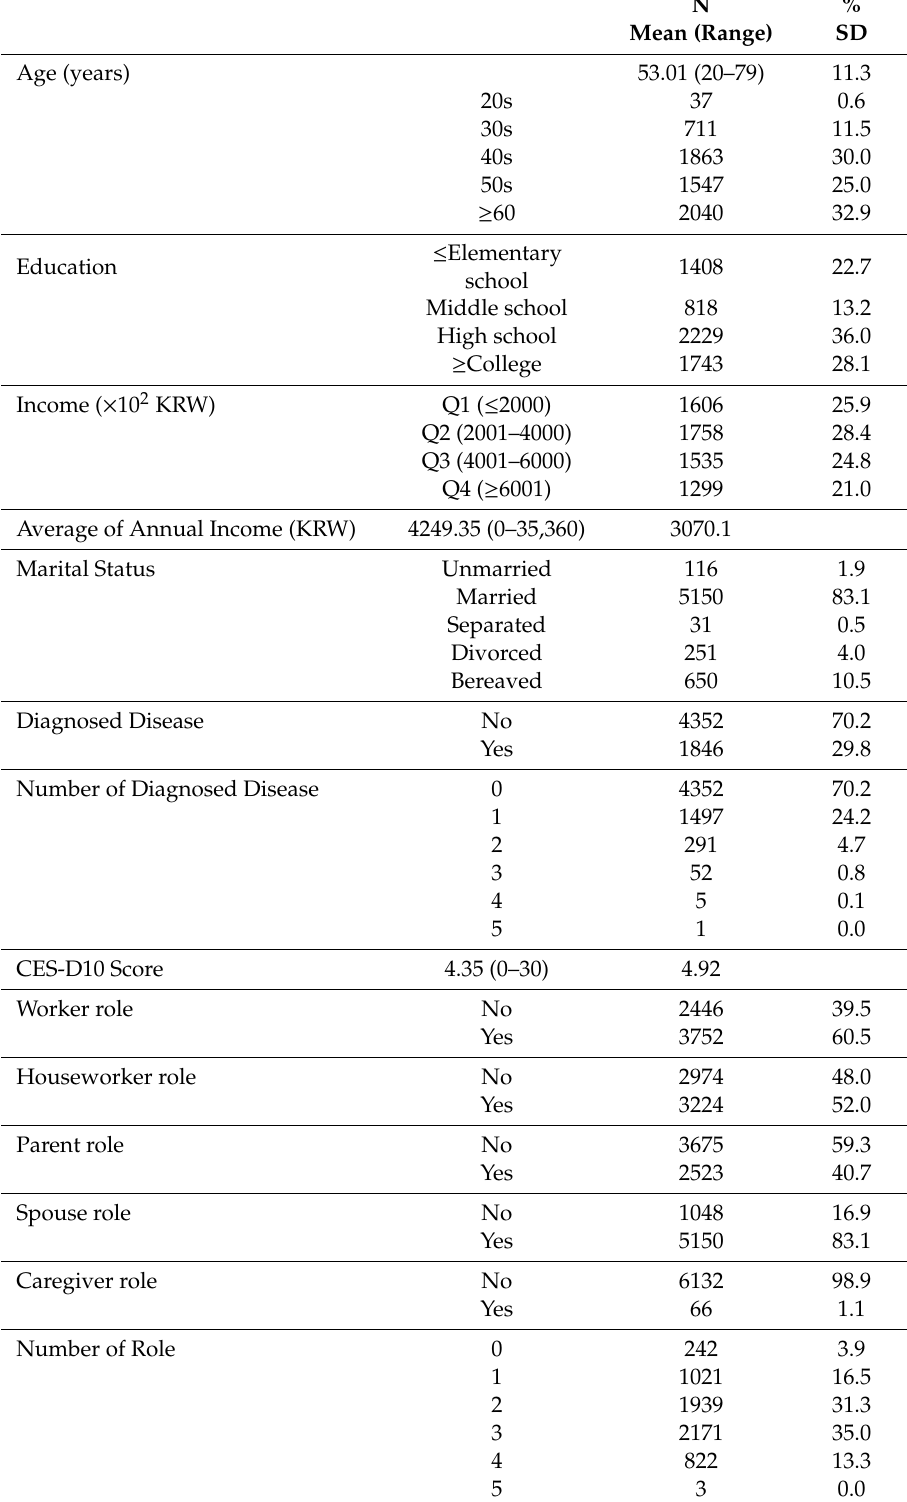
Table 1. Socio-demographic and role-related characteristics (N =